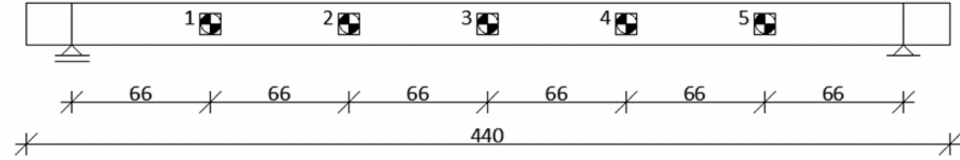
Figure 8. Sketch of target positions with corresponding